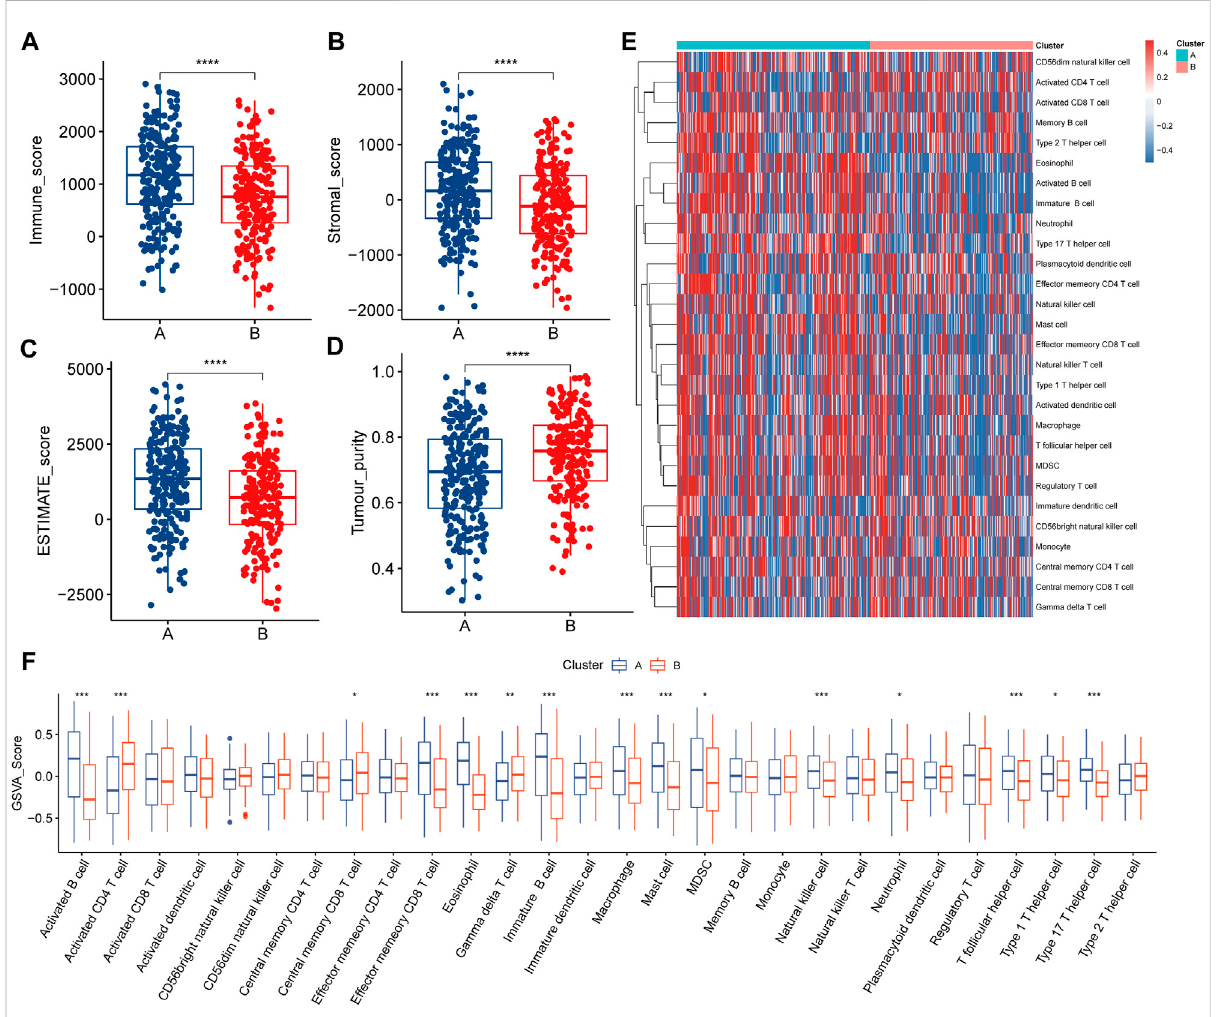
FIGURE 3 Immune characteristics of two lactate-related subtypes (A – D) Differences in the results of the four ESTIMATE analysis scores between the two subtypes (E) Landscape of 28 types of immune cell in fi ltration in patients with two subtypes, different colors represent different immune in fi ltration fractions (F) Differences in immune cell in fi ltration fractions in patients of two